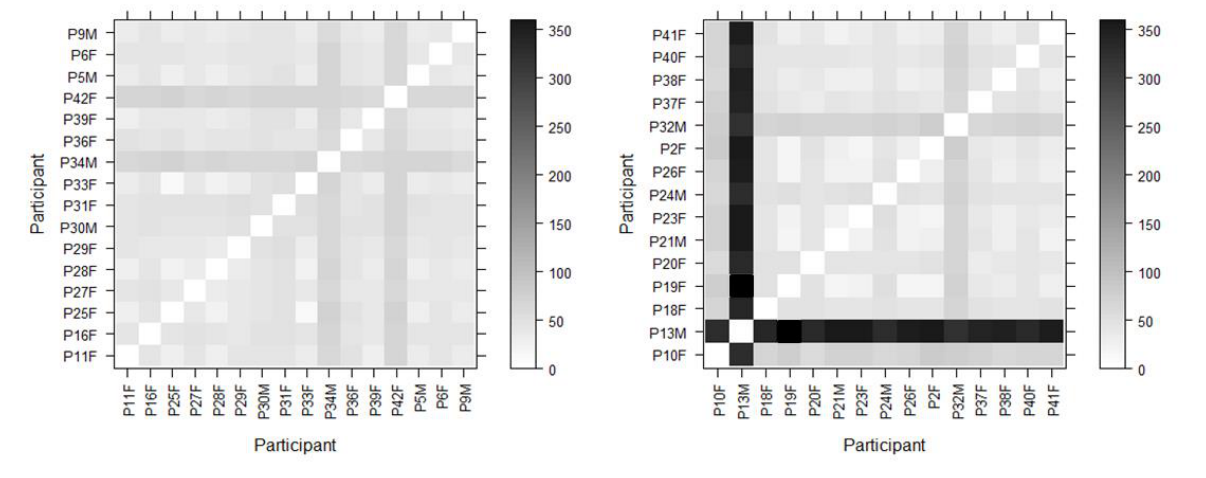
Figure 5. Levenshtein distance plots for correct (left) and incorrect (right) groups for the anterolateral STEMI ECG.